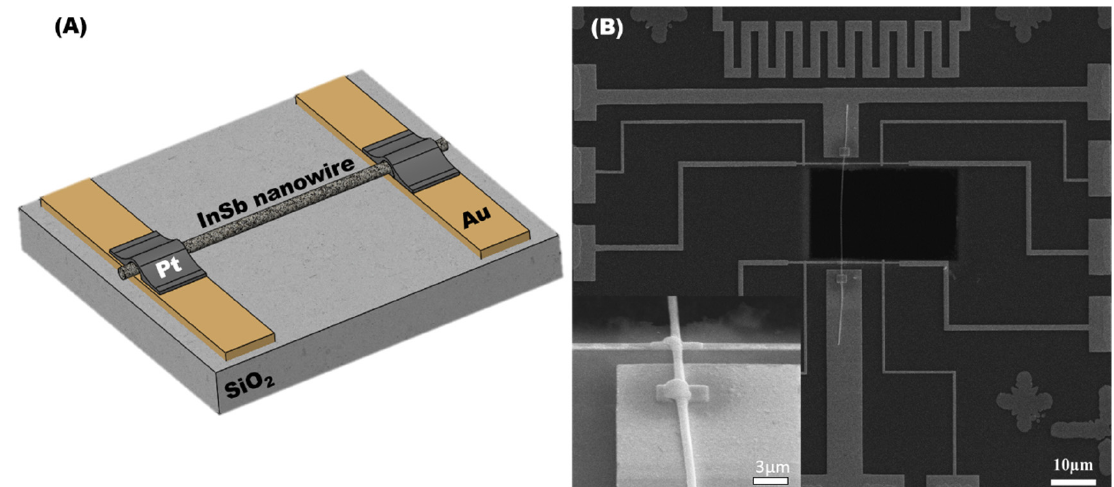
Figure 6. ( A ) Schematic representation of InSb P ‐ NW device fabrication; ( B ) the SEM image of the InSb P ‐ NW connected with a Pt electrode on Au ‐ patterned Si substrate, with a magnified image in the inset.